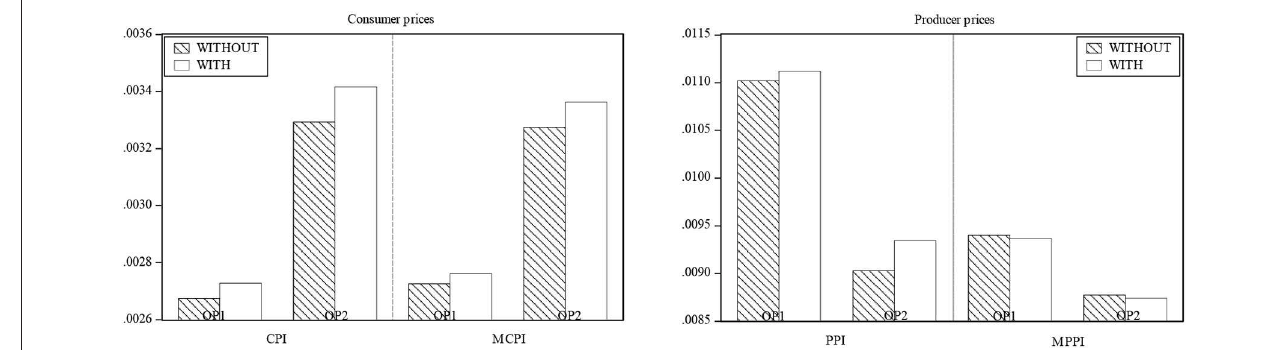
FIGURE 3 | The comparative pass-through of the oil price with and without a monetary policy.